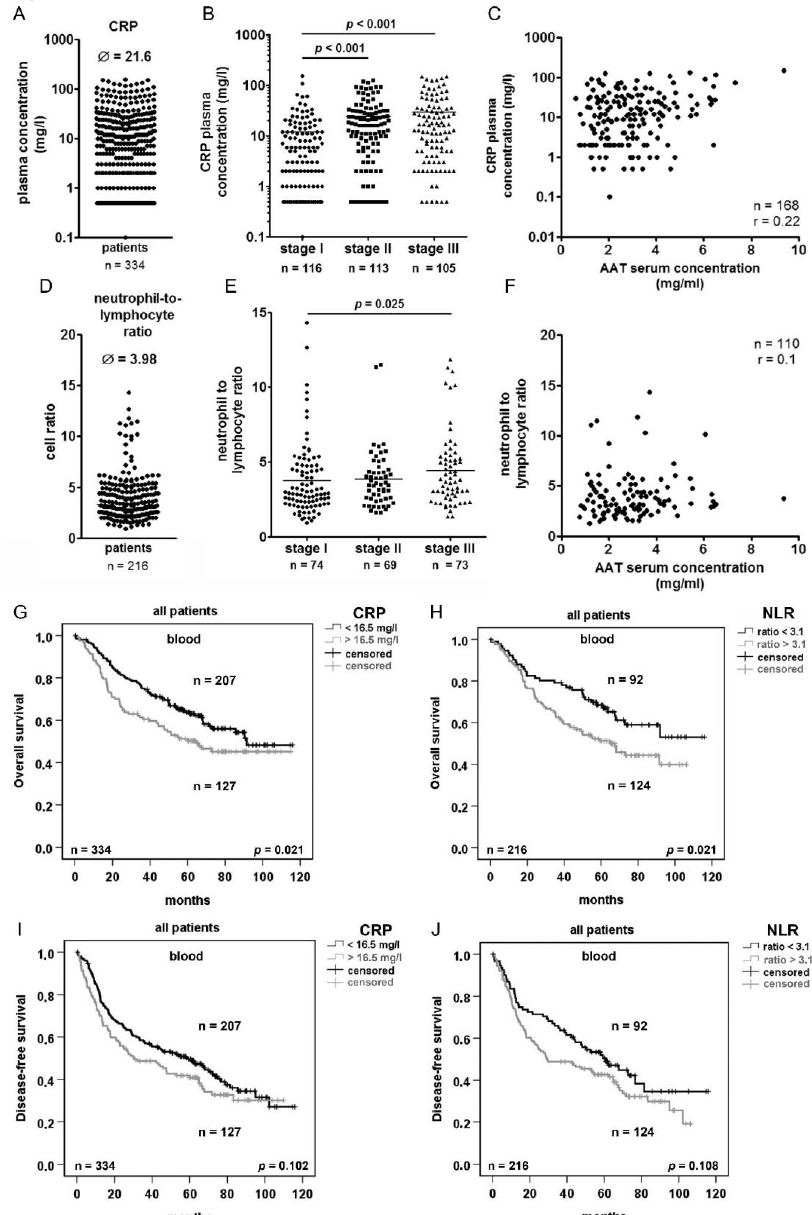
Figure 4. Elevated plasma CRP levels and a high neutrophil to lymphocyte ratio (NLR) are prognostic factors for the survival of NSCLC patients. ( A) ELISA- based quantification of serum CRP levels in 338 NSCLC patients. ( B) Serum concentrations of CRP in patients with cancer stage I, II and III. ( C) Correlation between serum concentration of AAT and CRP. ( D) Neutrophil-to lymphocyte ratio in 120 NSCLC patients. ( E ) Neutrophil-to-lymphocyte ratio in patients with cancer stage I, II and III. (F) Correlation between neutrophil-to-lymphocyte ratio and serum AAT concentration. ( G) and ( I) Kaplan-Meier overall and disease-free survival curves generated based on 16.5 mg/l cut-off of CRP to separate the two groups of patients. ( H) and ( J ) Kaplan-Meier overall and disease-free survival curves generated based on cut-off of 3.1 NLR to separate the two groups of patients. p < 0.05 was considered significant. r > 0.5 was considered as correlation.